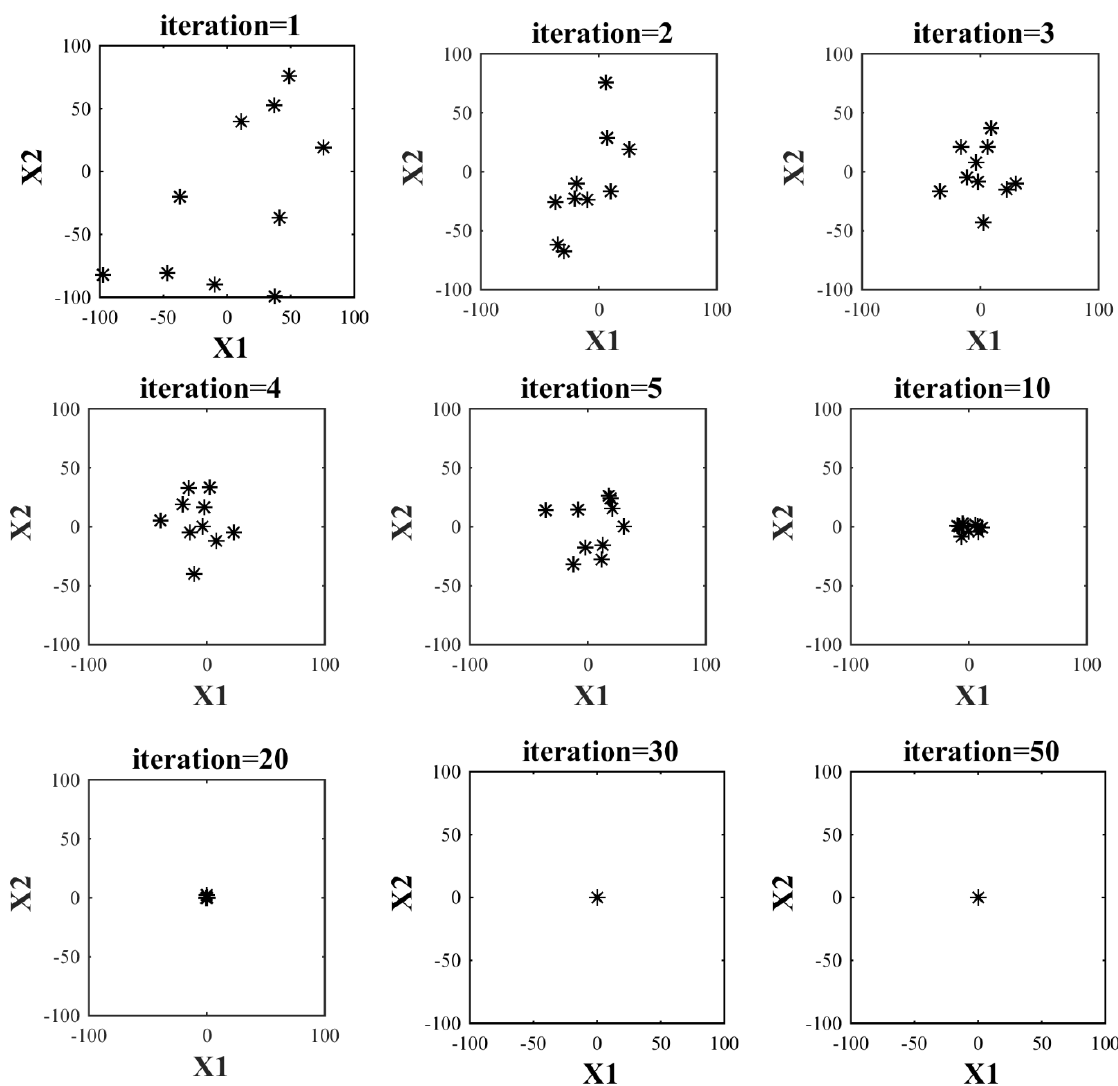
Figure 1. The flowchart of the Binary Spring Search Algorithm ( BSSA ).